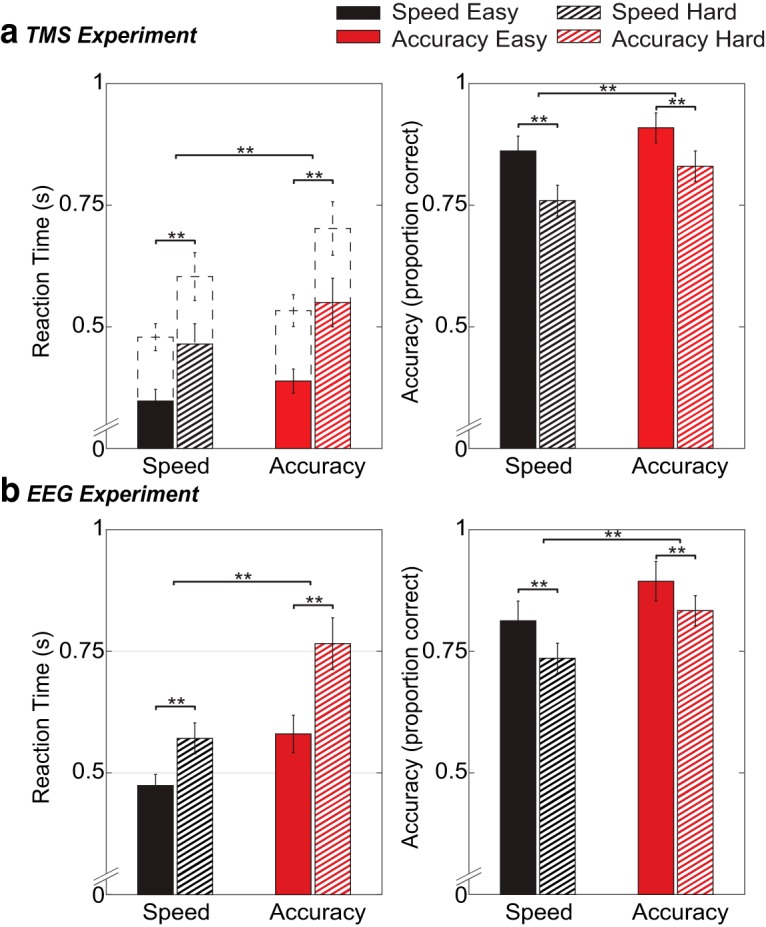
Behavioral results for both the TMS experiment (A) and the EEG experiment (B): reaction time (left) and accuracy scores (right) for each condition. Top left panel shows both EMG RT (bars) and button RT (dashed lines). Error bars indicate 95% confidence interval; **p <.001.